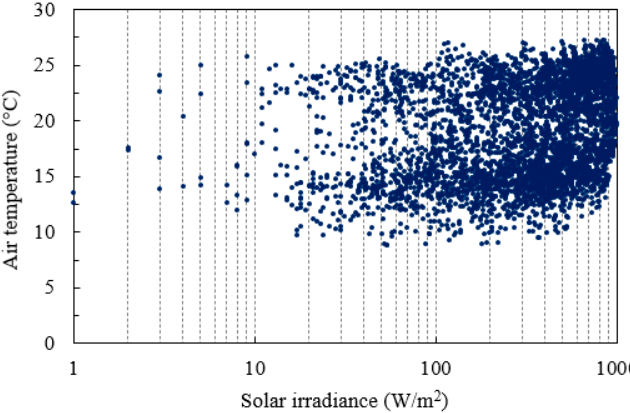
Figure 3. Solar irradiance/air temperature points at “Is Arenas” WWTP (Cagliari, Italy) [35].